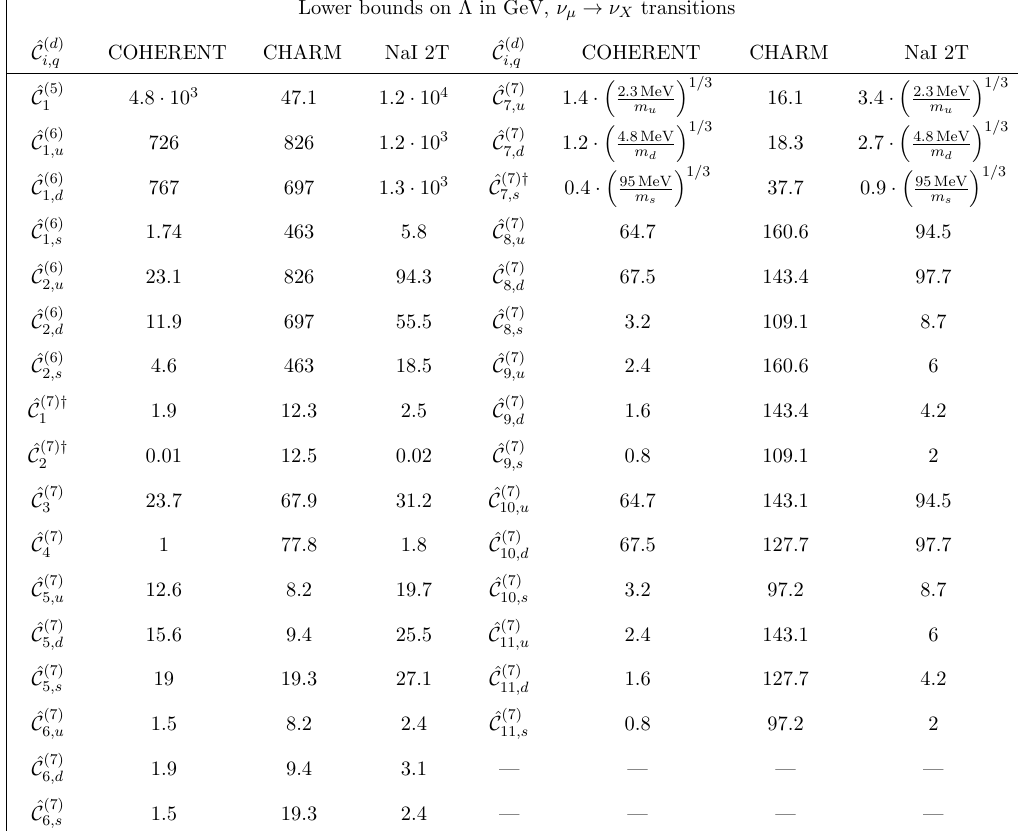
Table 3 . The 90 % C.L. lower bounds on (cid:3) from COHERENT, CHARM and NaI 2T for (cid:23) (cid:22) ( X = (cid:22) , for X = (cid:22) see main text) NSI Wilson coe(cid:14)cients, ^ 6 and assuming only one such NSI Wilson coe(cid:14)cient is nonzero. For ^ C (7) central value of the form factor (NDA estimates) so the bounds are merely indicative, see main text for